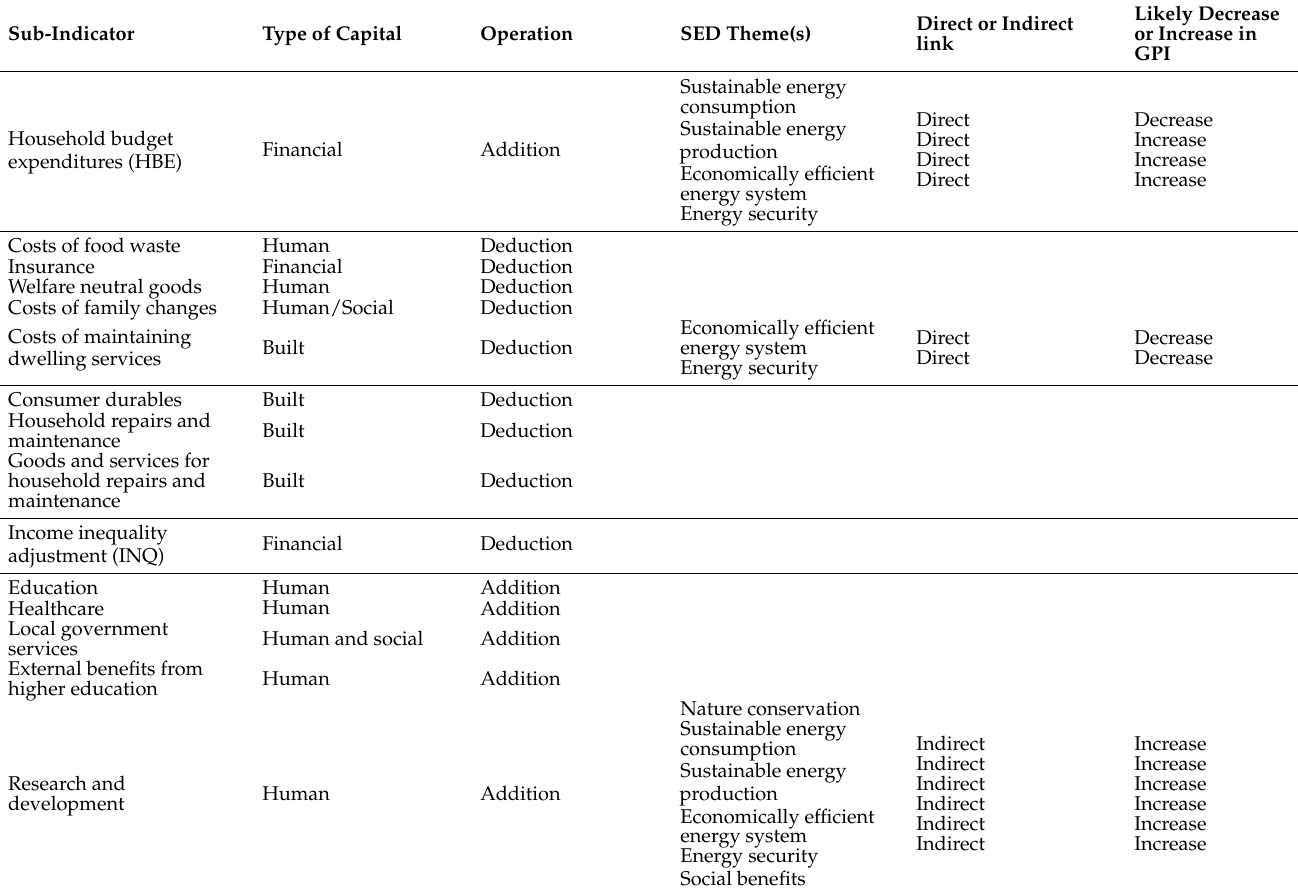
Table 3. SED and GPI